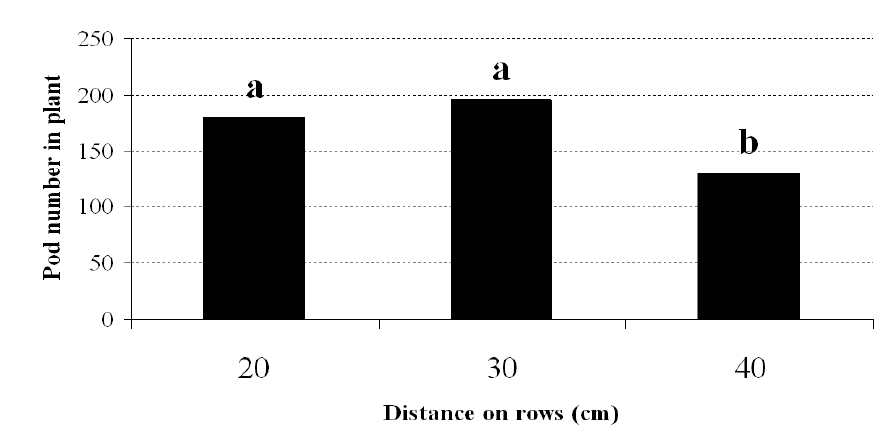
Fig. 8. Main effects of within row spacing on pod number in plant. All the values followed by the same letter in each column are not statistically different at the p<0.05 probability